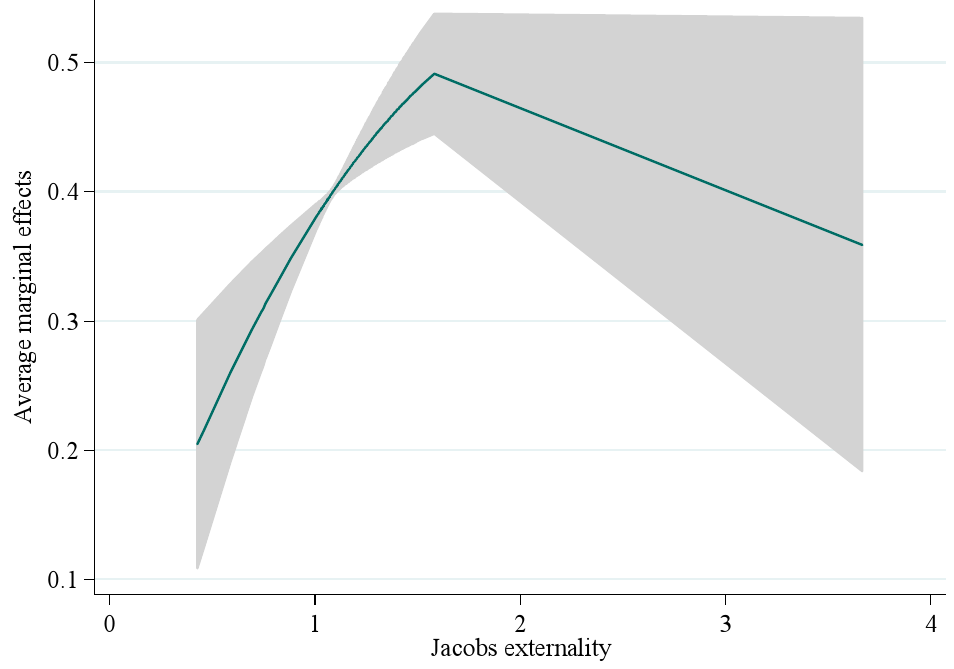
Figure 4. The average marginal effects of Jacobs externality on eco-efficiency.